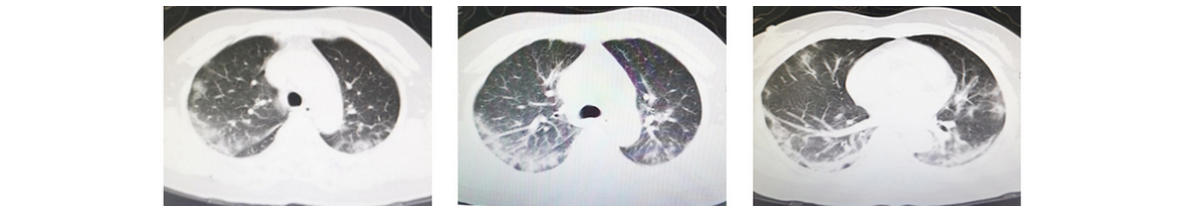
Figure 1. Chest computed tomographic images of a female patient aged 56 years infected with coronavirus disease. The images show ground glass opacity in both lungs on day 5 after symptom onset.